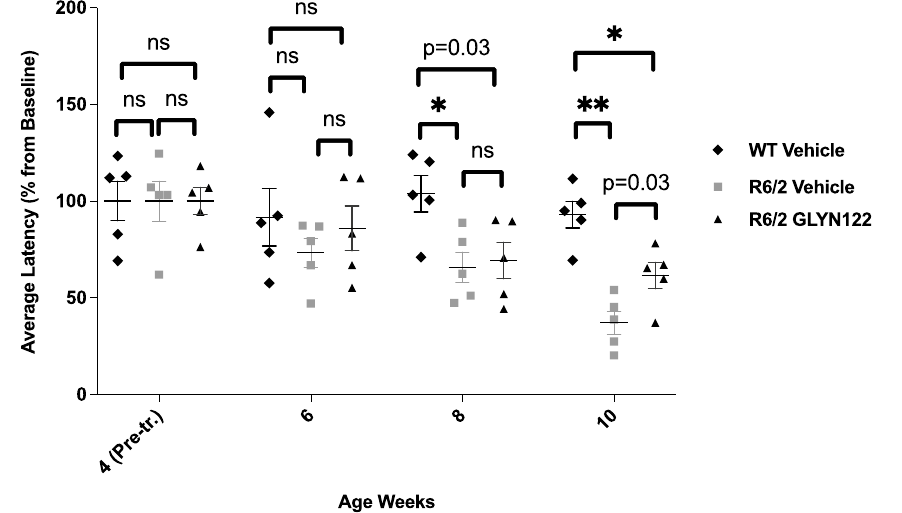
Figure 4. The effects of chronic administration of GLYN122 (33 mg/kg) on rotarod latency of female R6/2 mice at 4 to 10 weeks of age. Data are presented as percentage from 4-week pre-treatment baseline (mean + SEM) (WT Vehicle, n = 5; R6/2 Vehicle, n = 5; R6/2 GLYN122 33 mg/kg, n = 5). R6/2 GLYN122 33 mg/kg vs. R6/2 Vehicle. * p ≤ 0.01, ** p ≤